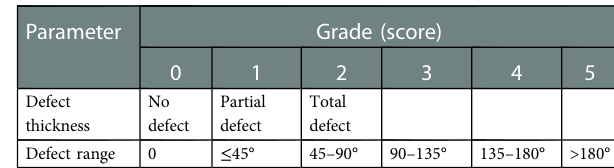
TABLE 1 Scoring standard of sphincter damage degree.